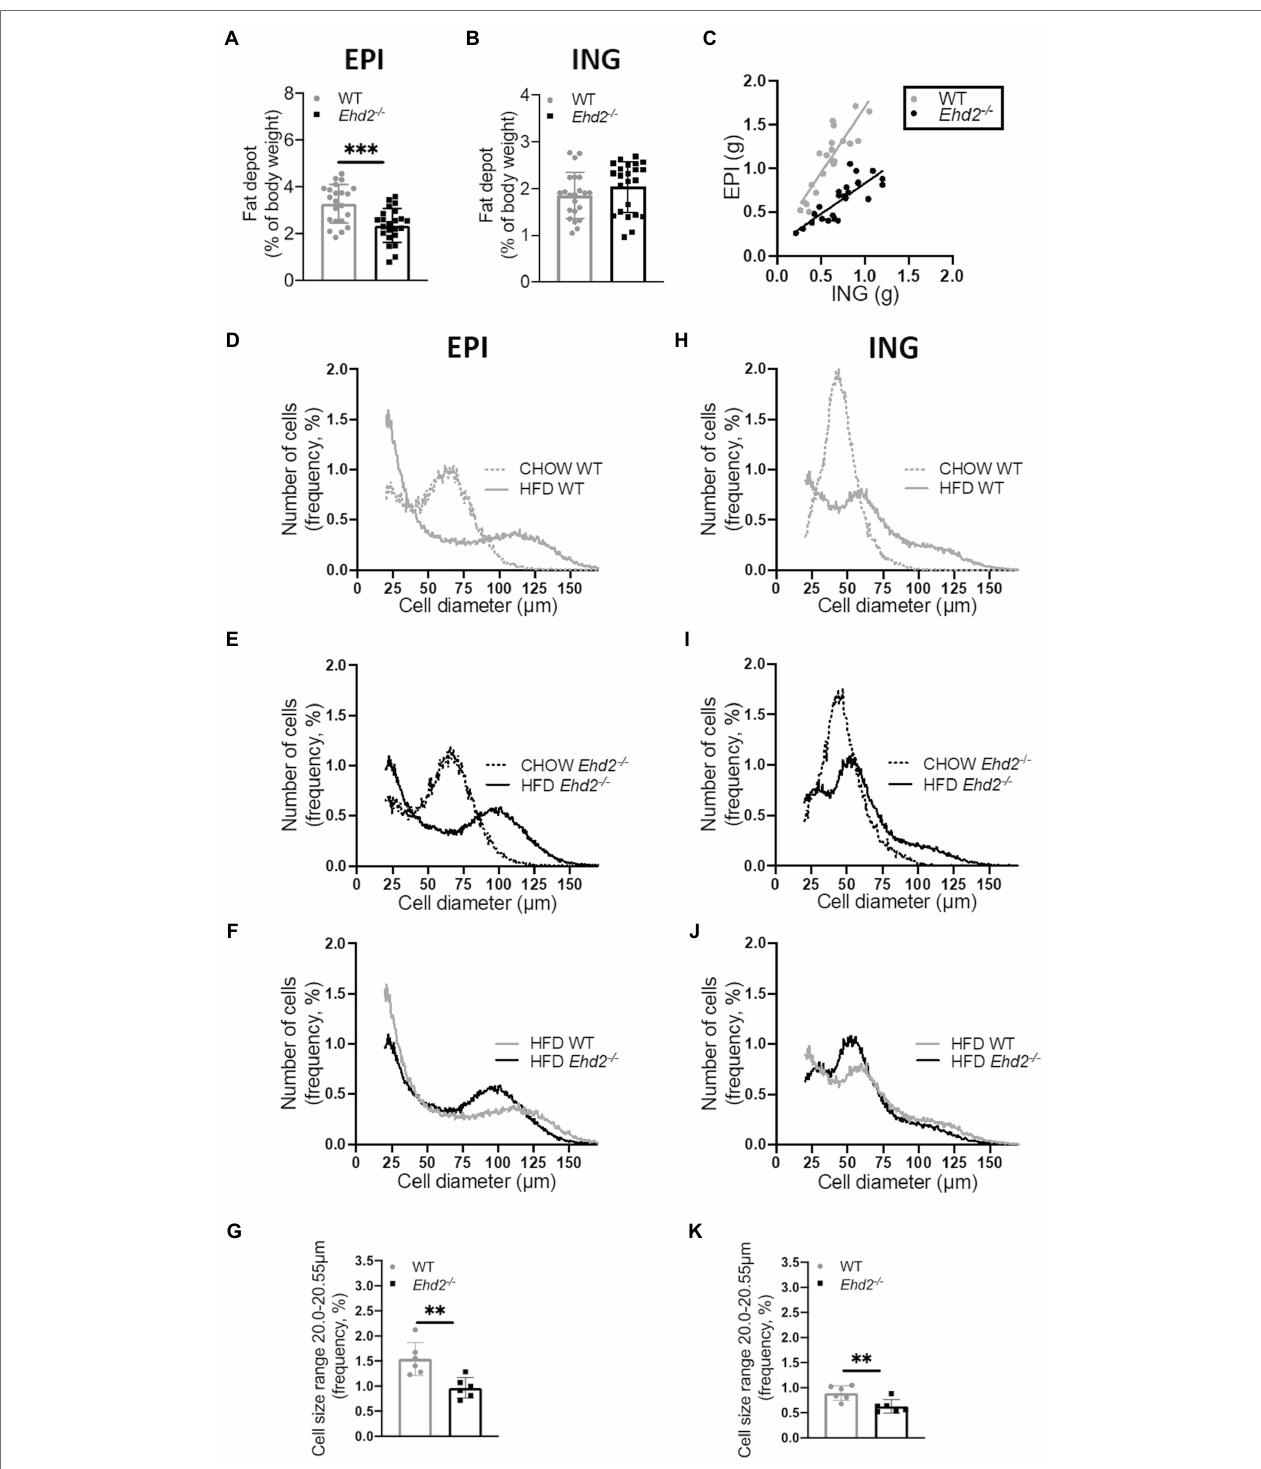
FIGURE 3 | Adipose tissue expansion and adipose cell size distribution in Ehd2 − / − and WT mice following 2 weeks of HFD-feeding. (A,B) Depot weights of EPI and ING adipose tissue ( n = 22–23 animals/group) collected after 2 weeks of HFD. (C) Correlation of EPI and ING weight, each symbol (gray = WT, black = Ehd2 − / − ) represent one animal, line shows simple linear regression analysis. Adipose cell size distribution obtained by coulter counter in EPI (D–F) and ING (H–J) depots. Data displayed as average from n = 3 samples in chow/group, and n = 6 samples in HFD/group. (G,K) Frequency percentage of small cells (cell diameter 20.00– 20.55 μ m) from HFD-fed mice; EPI (G) and ING (K) , data obtained from cell size distribution curves, shown in (F,J) . Data in (A,B,G,K) are presented as mean ± SD, and ** p < 0.01 and *** p < 0.001 were calculated using unpaired two-tailed Student’s t